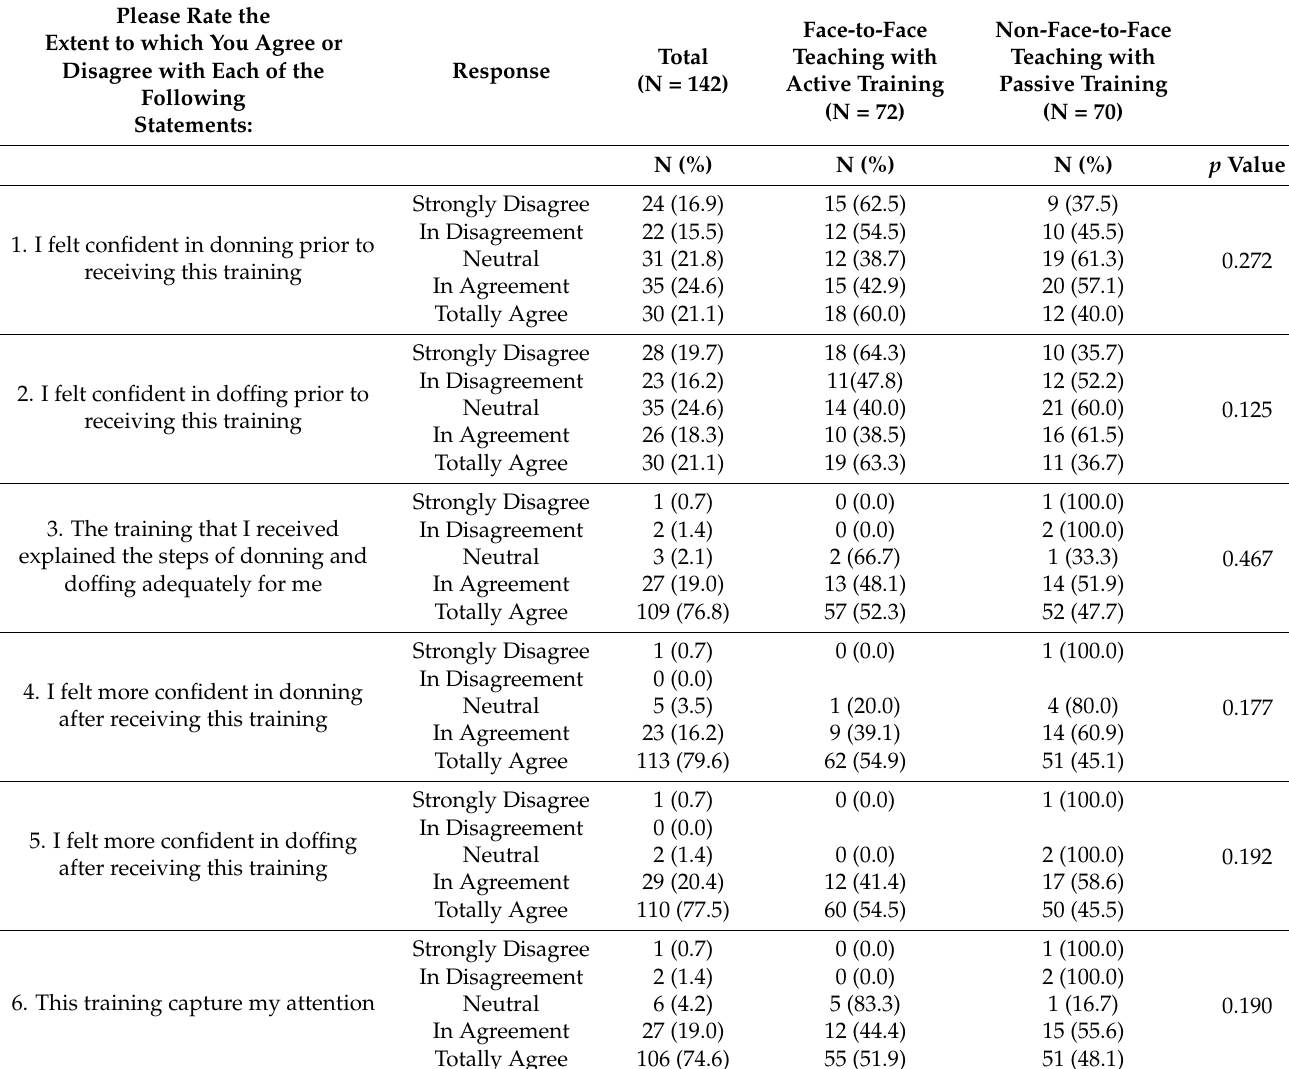
Table 2. Self-assessment of the management of PPE in the total study population and according to the training modalities (response options as categorical